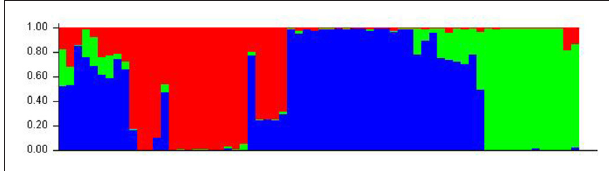
FIGURE 6 | Population structure of a panel of 66 landraces and breeding lines arranged on the basis of membership probability fractions of individual genotypes. The membership fractions, the genotypes with the probability of ≥ 80% were assigned to corresponding subgroups with others categorized as